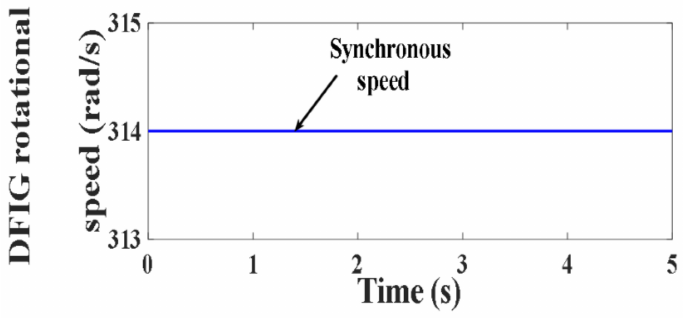
Figure 44. Prime mover operating speed